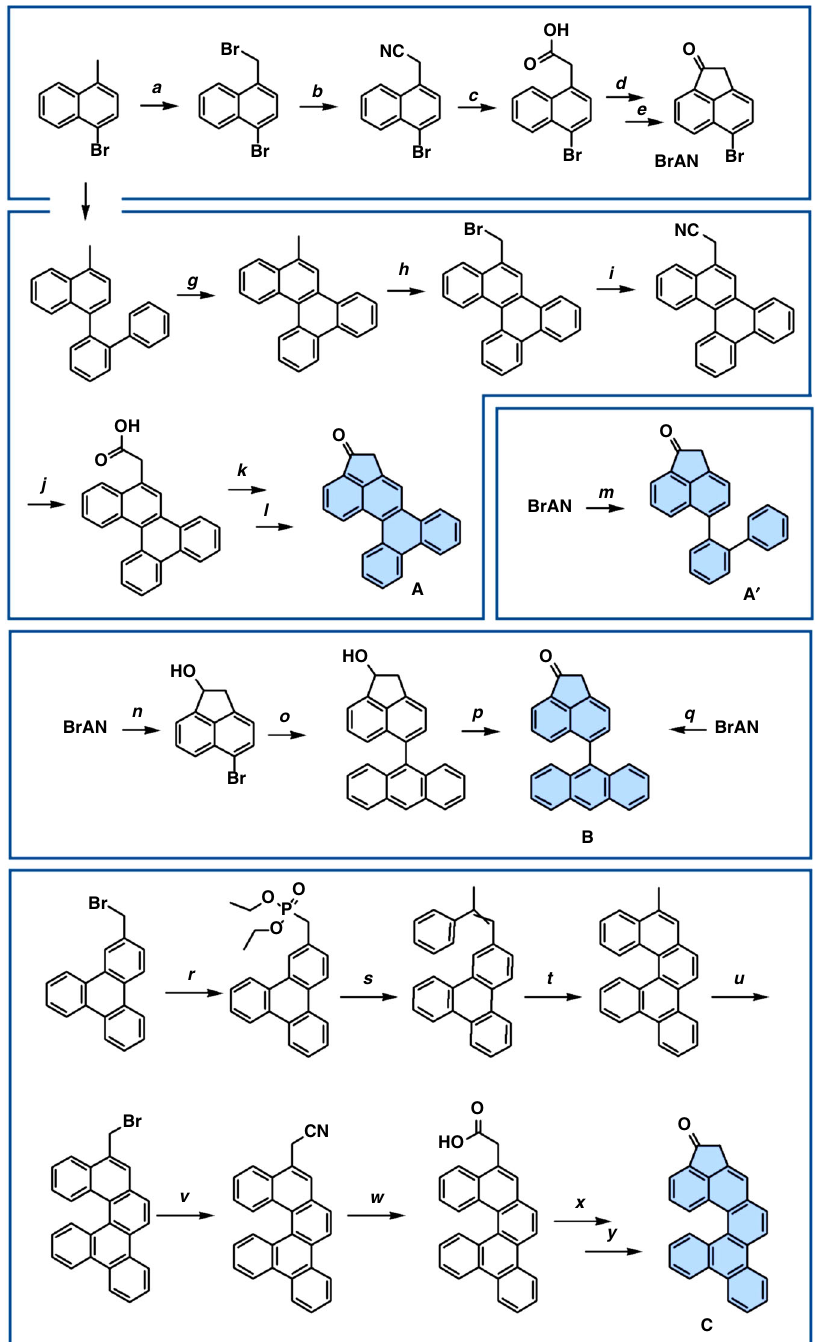
Fig. 3 Synthesis of segments A , A ′ , B and C . a ) NBS, DBPO, DCM, re fl ux; b ) KCN, TBAB, DCM, H 2 O, 12 h at RT, 89%; c ) H 2 SO 4 , H 2 O, HOAc, 12 h re fl